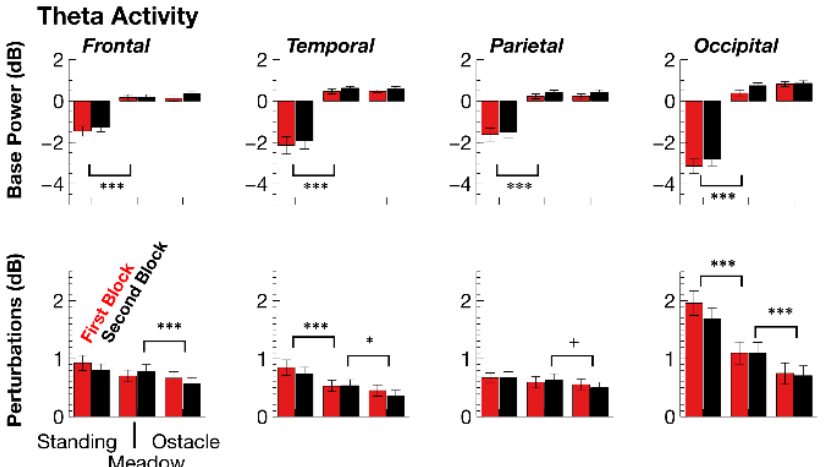
Figure 5. Level of Theta power and task ‐ related perturbations (means and standard error of means) for the three walking conditions and separated for the two blocks. Theta level was higher for stand ‐ ing compared to both walking conditions. Theta perturbations decreased in power with increasing complexity of the walking conditions. Significant effects of walking condition are depicted for all pairwise comparisons (***: p < 0.001; *: p < 0.05; +: p < 0.1).